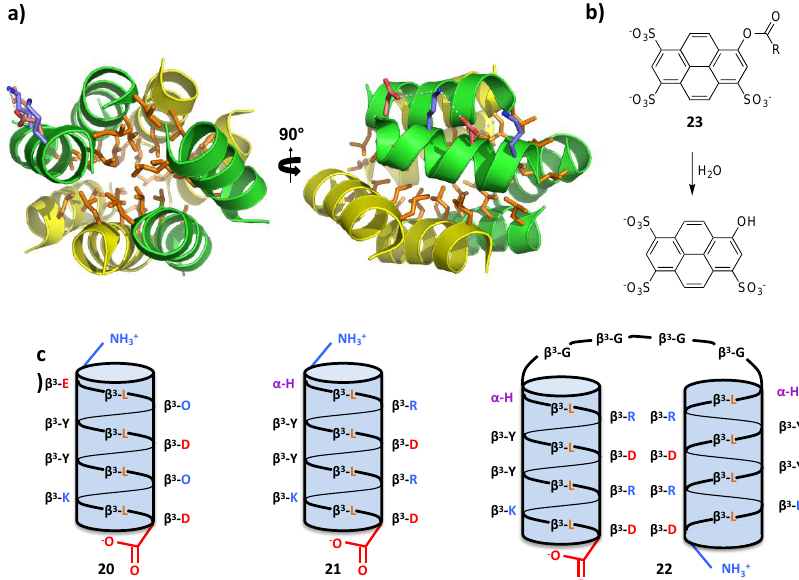
Figure 5. ( a ) Structure of the octameric Zwit-EYYK bundle (CCDC 804687). Key residues for the bundle stabilization are depicted as follows: orange: β 3 -hLeu; blue: β 3 -hOrn; and red: β 3 -hAsp. ( b ) Hydrolysis of 8-acetoxypyrene-1,3,6-trisulfonate 23, chosen as a model reaction. ( c ) Helical net diagrams of Zwit-EYYK 20 and esterolytic-active β 3-peptides 21-22